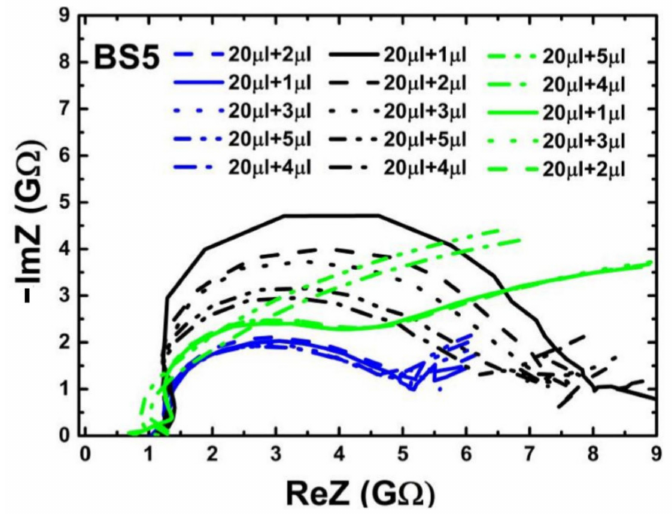
Figure 9. Nyquist plot of extracted effective impedance (Z( ω )) from the equivalent circuit model Figure 7b for BS5. The extracted effective impedance is represented for dead (black lines), for live (green lines), and for DI water sample (blue lines). Nearly systematic/not fully systematic change of effective impedance (ReZ and Im Z) when adding liquid with dead/live cells to 20 µ L DI water is